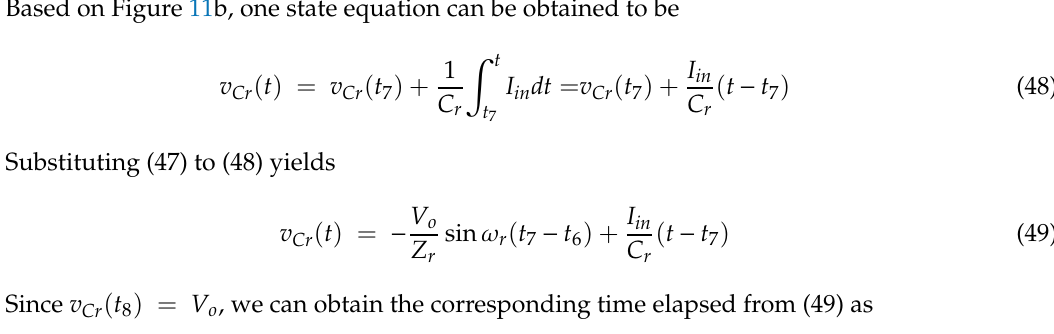
Table 1. System and specifications (CCM: continuous conduction mode).